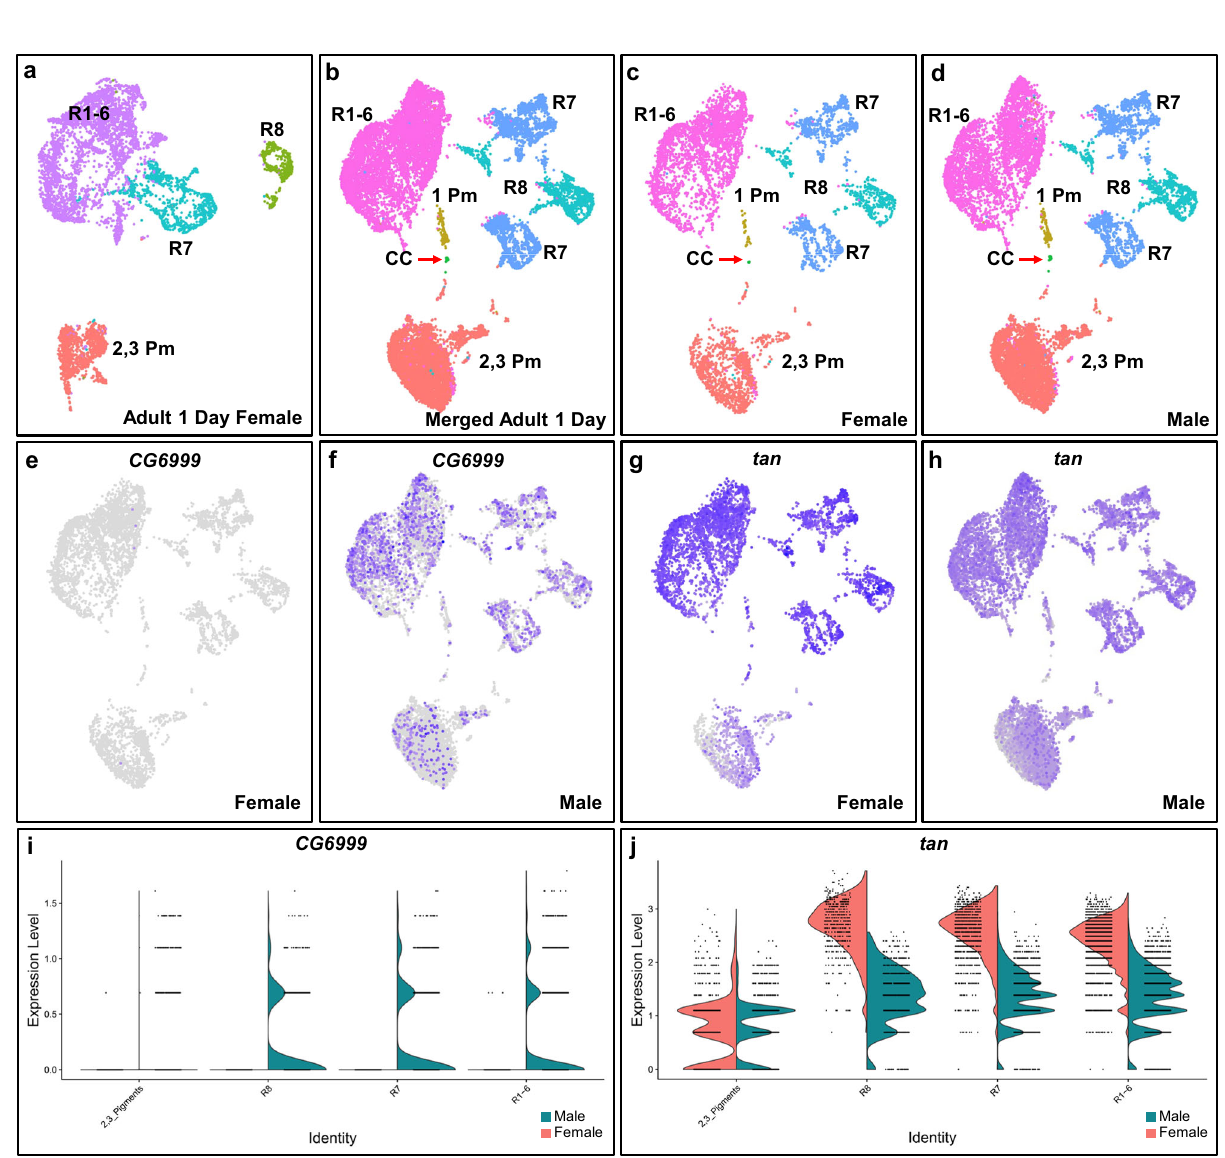
Fig. 6 One-day-old adult male and female eyes have highly similar transcriptomes. a Major cell type clusters are annotated on a Seurat UMAP cluster plot of 1-day-old adult female eye scRNA-seq. R1-6 (purple), R7 (blue), and R8 (green) label R1-8 photoreceptor clusters and PM (orange) labels pigment cell clusters. b Male and female adult eye scRNA-seq integrated into one Seurat UMAP cluster plot using Harmony. c , d Integrated male and female scRNA-seq cluster plot but split into female only ( c ) and male only ( d ) cluster plots. e , f FeaturePlots of CG6999 , one of the two genes that show a male/ female speci fi c expression pattern. g , h FeaturePlots showing tan as an example of a gene that was called as a potential male or female-speci fi c gene but shows no male or female speci fi city. All cells expressing CG6999 and tan were brought to the front in FeaturePlots ( e – h ). i , j ViolinPlots showing log- normalized CG6999 and tan expression in male and female cell types. Primary pigment and cone cells are omitted (see main are expressed in most male cells but not in the vast majority of expressed in a sex-speci fi c pattern. However, 687 of these female cells (Fig. 6e, f, i and Supplementary Fig. 10). In addition, potential sex-speci fi c marker genes are expressed in both male most of the called sex-speci fi c genes are expressed at similar levels and female cells with no clear bias for either sex. The only and in similar patterns between male and female cells. Only 21 exceptions are CG6999 and apolipophorin ( apolpp ), both of which